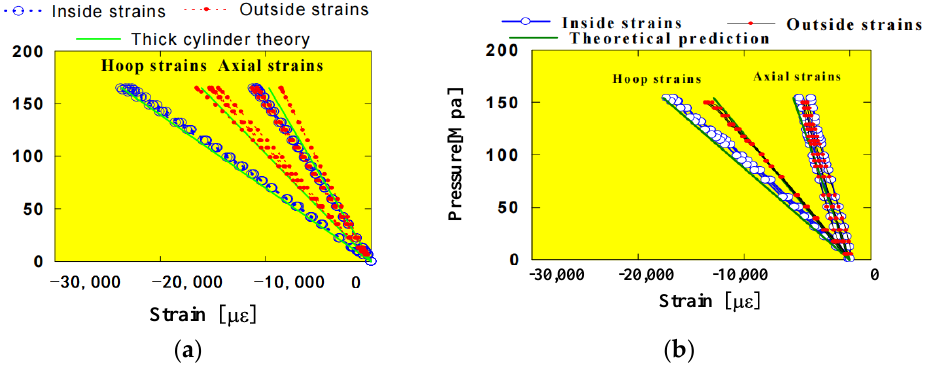
Figure 6. Pressure-strain curves for the ± 55 ◦ composite tubes under SR = − 2/ − 1 [71]. ( a ) D = 51 mm, h = 9.23 mm, S2-hollow glass; ( b ) D = 51 mm, h = 6.91mm, S2-solid glass.